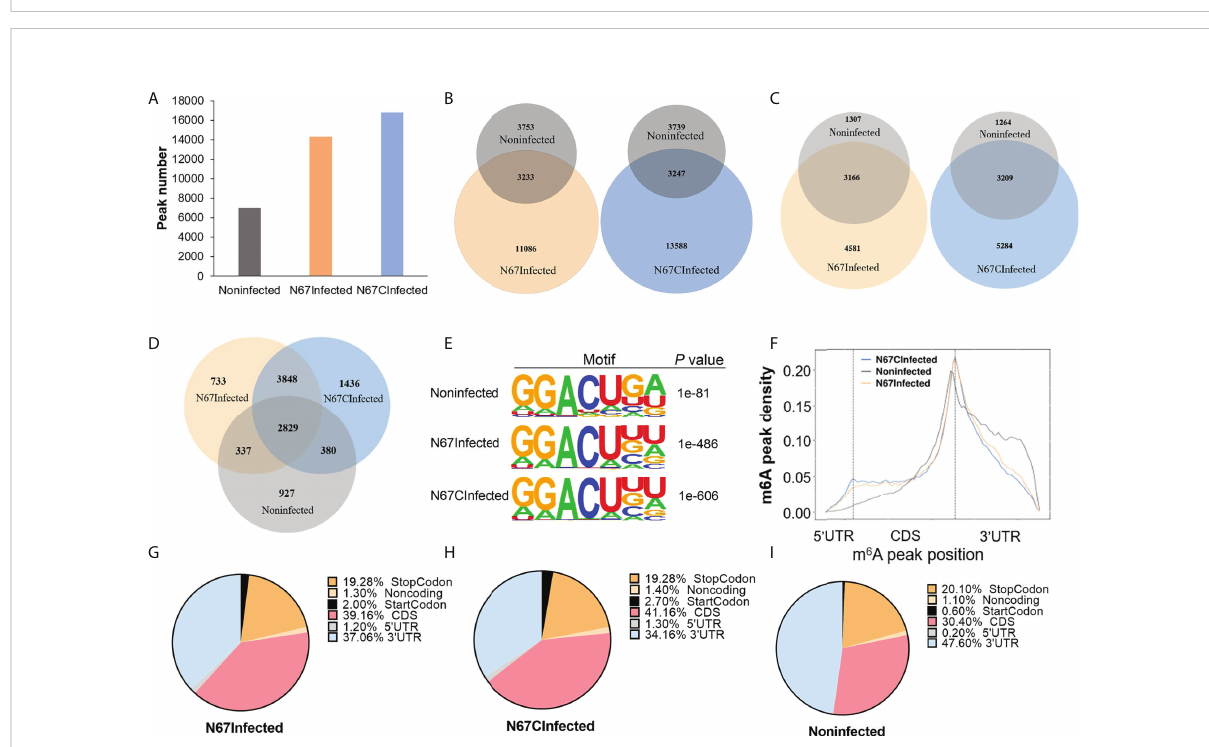
FIGURE 2 Malaria parasite infections in mice alter host spleen mRNA m 6 A methylome pro fi les. (A) m 6 A peak number identi fi ed from MeRIP in N67-, N67C- infected or noninfected spleens. (B) Venn diagrams showing the differences and overlaps of m 6 A peaks identi fi ed from MeRIP between N67- or N67C-infected and noninfected spleens, respectively. (C) Venn diagrams showing the differences and overlaps of m 6 A-containing genes between N67- or N67C-infected and noninfected spleens, respectively. (D) Venn diagram showing the differences and overlaps of m 6 A- containing genes among N67-, N67C-infected and noninfected spleens. (E) Consensus motifs and corresponding P values of m 6 A peaks identi fi ed by HOMER from m 6 A-seq analysis. (F) m 6 A peak distribution across the mRNA regions (5 ’ UTR, CDS, 3 ’ UTR). m 6 A peaks were mapped to the corresponding gene and plotted according to their position. (G) Pie chart showing the proportion of m 6 A peaks in different mRNA regions of N67-infected mice spleens. (H) Pie chart showing the proportion of m 6 A peaks in different mRNA regions of N67C-infected mice spleens. (I) Pie chart showing the proportion of m 6 A peaks in different mRNA regions of noninfected mice